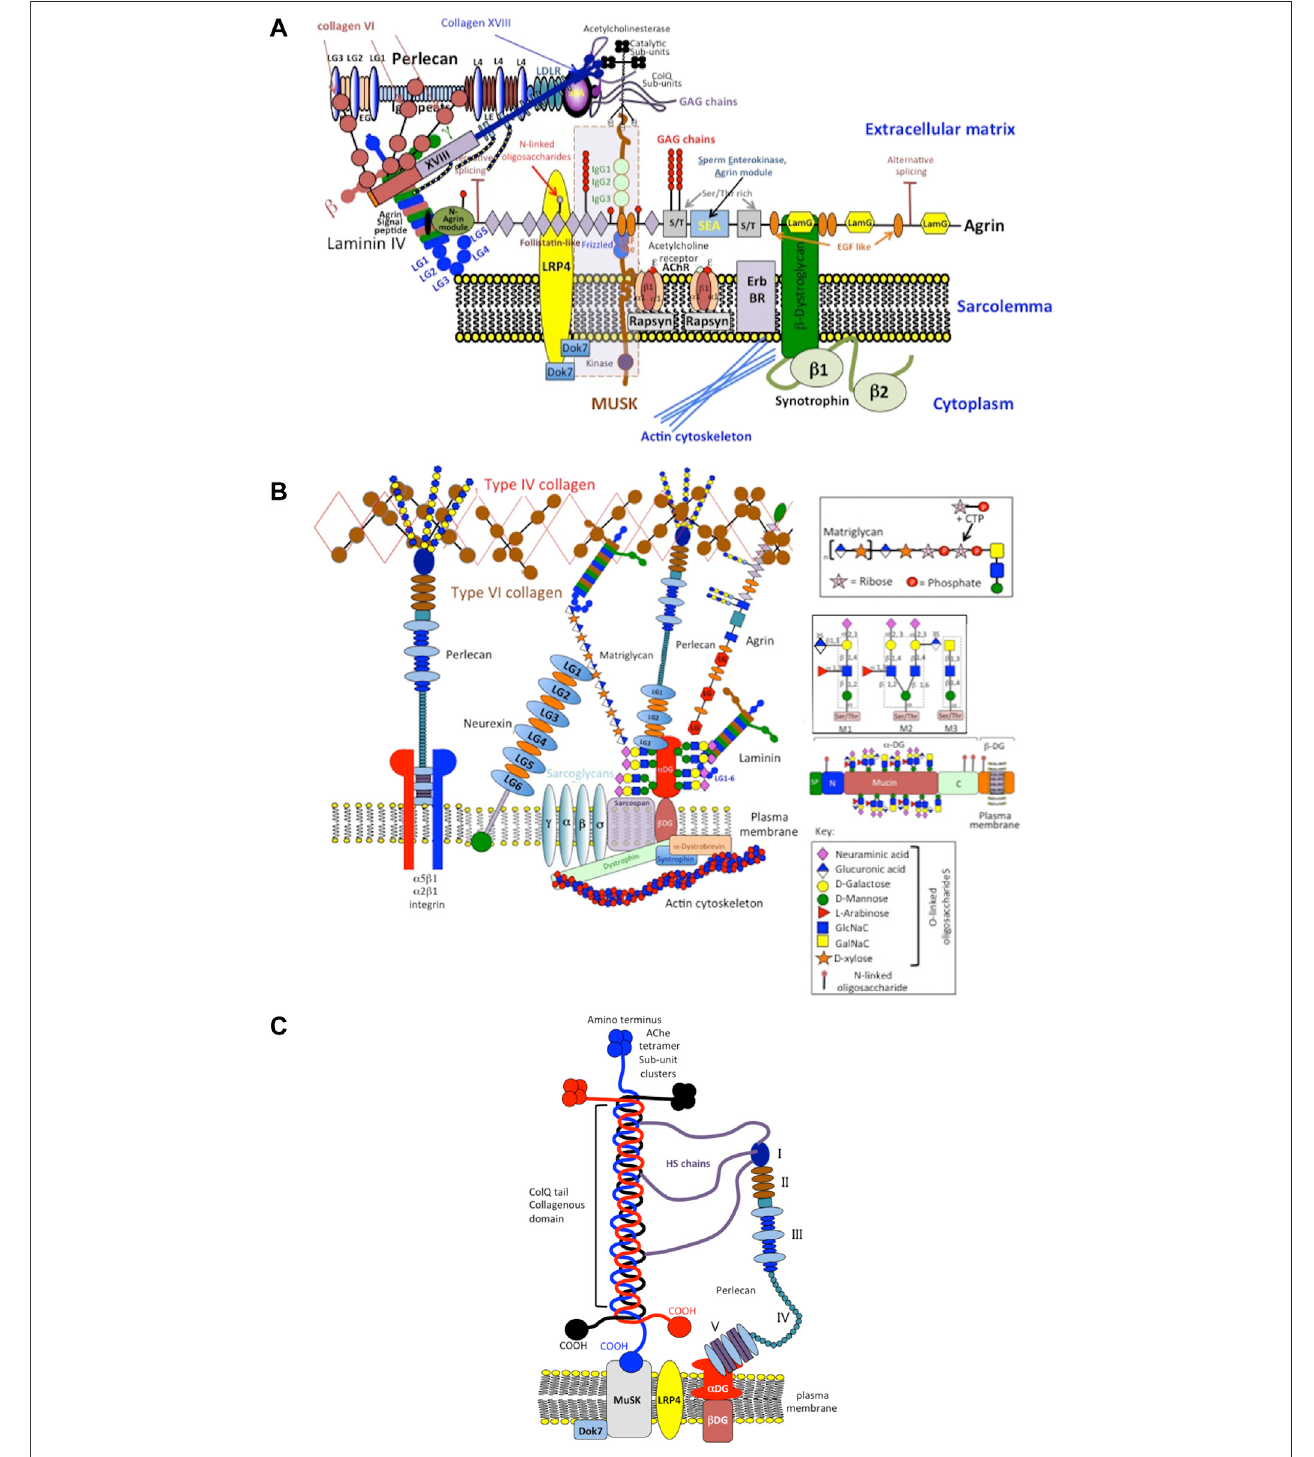
FIGURE 5 | Schematic depiction of perlecan ’ s role as an integral structural component involved in the assembly and function of the neuromuscular junction (NMJ) showingitsinteractionswithcellsurfaceintegrins,typeIV,VI,XVIII,ColQcollagens,MuSK(Muscle-Speci fi cKinase)anddystroglycan(DG)andlocalizationofcatalytically active acetylcholinesterase sub-units (A) . Other structural components of the NMJ include extracellular components such as matriglycan, neurexin, laminin, type XVIII collagenandagrinandthecellmembranecomponentsMuSK,sarcoglycan,dystrophinandsarcospan (B) .Thisschematicisasimpli fi edinterpretationofdatafrom the many publications that have outlined theverycomplexstructure and function ofthe NMJ (Geppert et al.,1992; Crosbie et al.,1999; Arikawa-Hirasawa et al.,2002b;